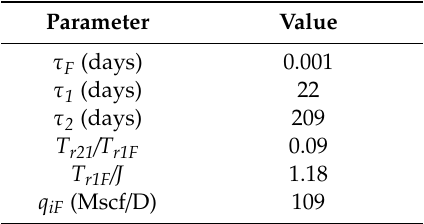
Figure 4. Reservoir grid for the numerical cases showing di ff erent shapes of stimulated region. The red grids are the stimulated region and the blue ones are the low-permeability region. Table 2. Model parameters used in the analytical model for validation against numerical simulation.